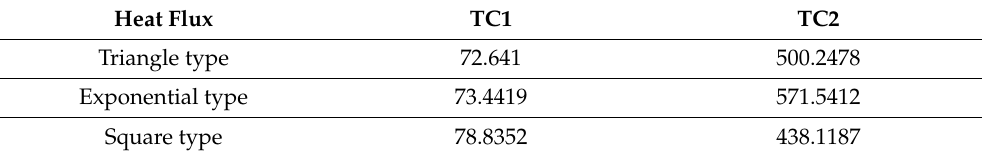
Table 3. Inversion error under three different types of heat